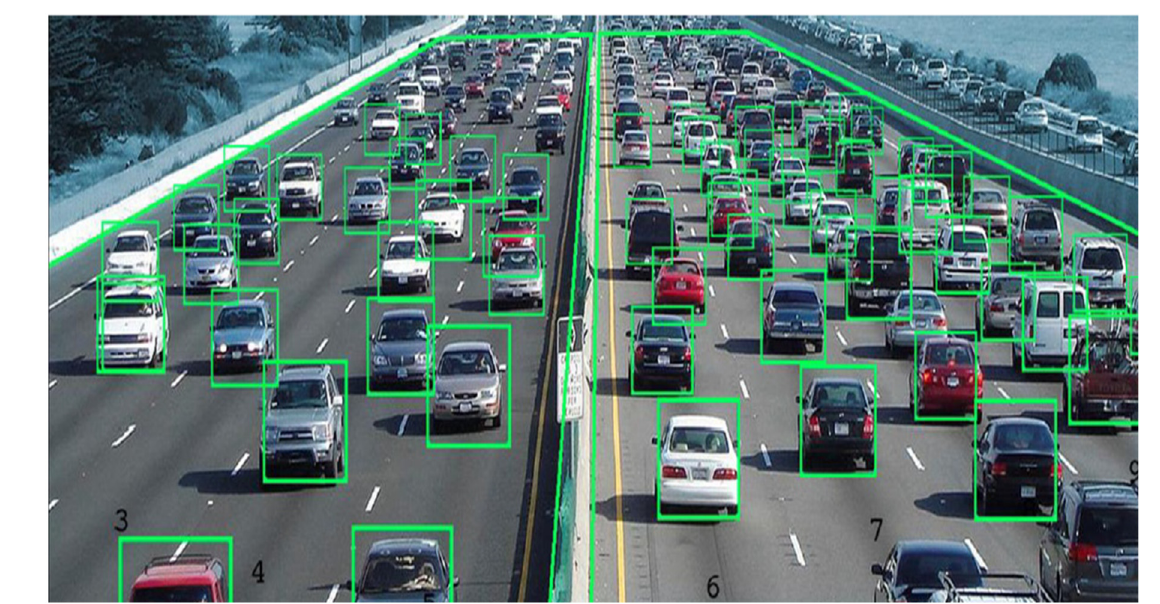
Figure 4. Example of an Image processing System from Video Cameras. Reprinted with permission from ref. [64]. Published by Elsevier B.V.Copyright © 2016 Elsevier Ltd. All rights reserved.